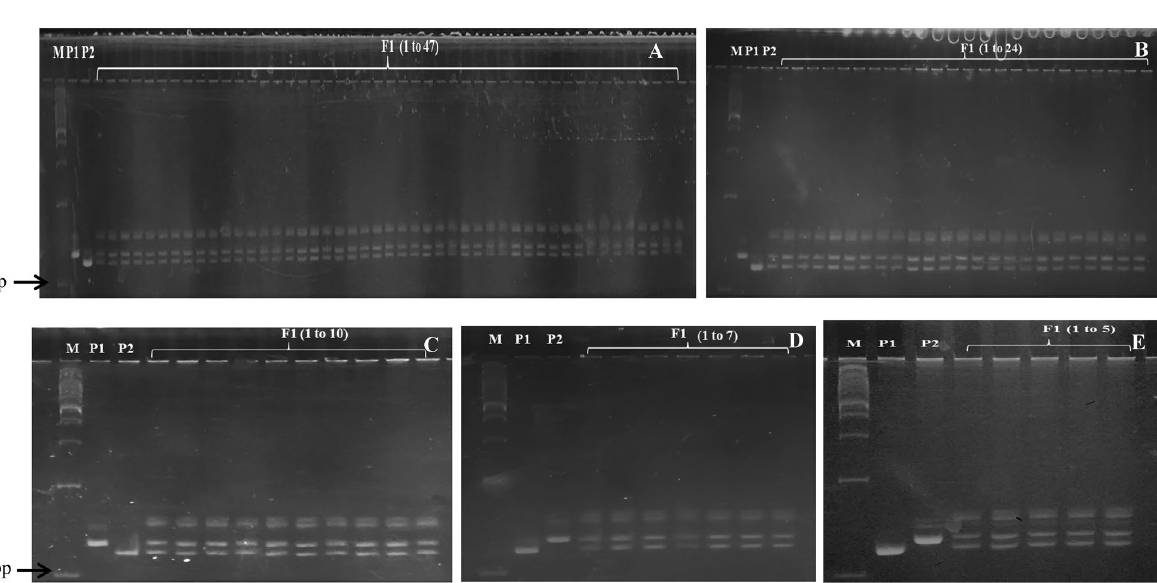
female parent (0.65–0.72 kg), whereas, the reciprocal crosses revealed the intermediacy (0.61–0.71 kg). Numbers of seeds per fruit obtained from interspecific F 1 plants were ranged from 25.33 to 89.67 compared with 94.67 to 316.67 of the parents. The interspecific F 1 hybrids revealed divergence from their parents with respect to mor- phological traits, indicating the hybridity. Micromorphological characterization. The micromorphological traits, such as trichomes and stomatal aperture on abaxial leaf surface of parents and their interspecific F 1 plants were examined through scanning electron micrography (Table 5, Supplementary Figs. 2 and 3). The trichome density of C. pepo varied from 3.00 to 3.40 per 100 μm 2 , C. moschata from 3.60 to 4.00 per 100 μm 2 , and their interspecific F 1 hybrids were significantly enhanced from their respective female parent in Family II (4.40 per 100 μm 2 ), transgressive to both the parents in Family III (4.80 per 100 μm 2 ) and intermediate to both the parents in Family I, IV and V (3.60, 3.40 and 3.40 per 100 μm 2 ), indicated hybridity. Further, the hybridity was assessed with trichome length, which revealed that C. moschata exhibited longer trichomes (286.89–485.73 µm) in comparison to C. pepo (178.78–364.66 µm). While their interspecific F 1 hybrids were intermediate in Family II (310.01 µm) and III (434.25 µm), transgres- sive in Family IV (404.62 µm), and statistically different from female parent in Family I (284.13 µm) and from male parent in Family V (305.48 µm) for trichome length. Trichome width and stomatal complex length were also analyzed for the confirmation of hybridity, however results were non-significant between parents and their interspecific hybrids except Family I and II for trichome width.